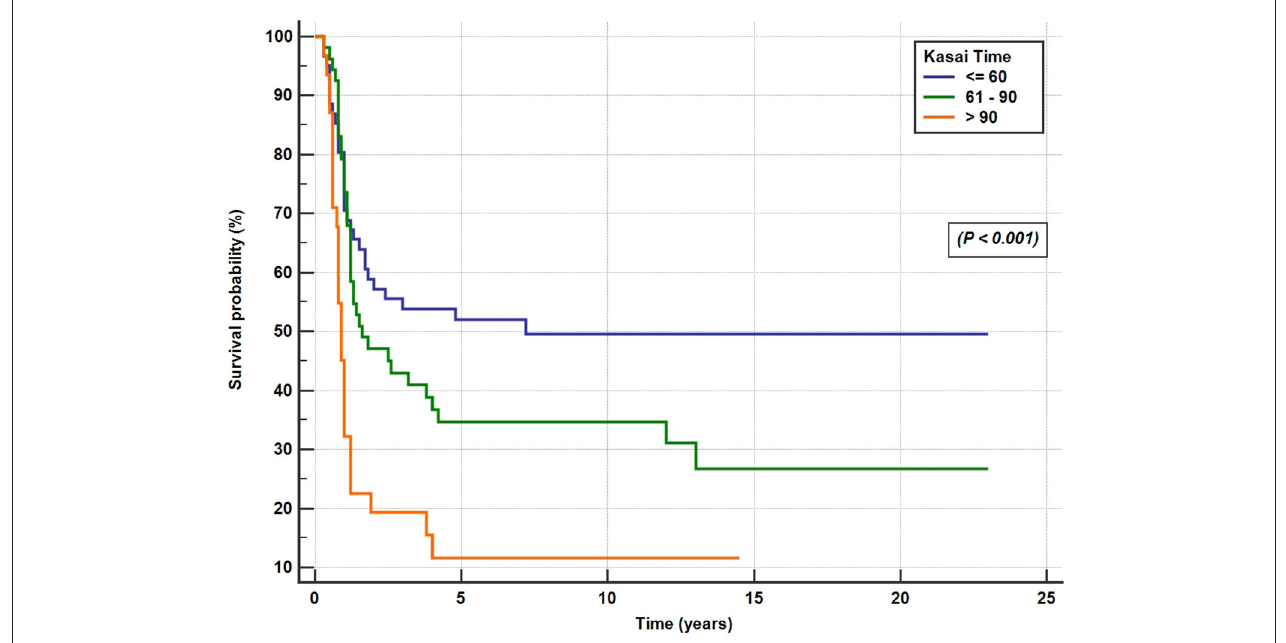
FIGURE 5 | Post-Kasai operation native liver survival rate for the patients who underwent the Kasai surgery at the age of < 60 days, 61–90 days, and > 90 days.